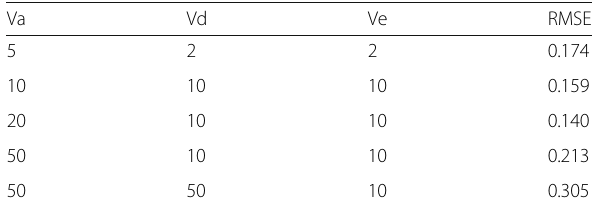
Table 7 Prediction deviation of multi-node single-feature